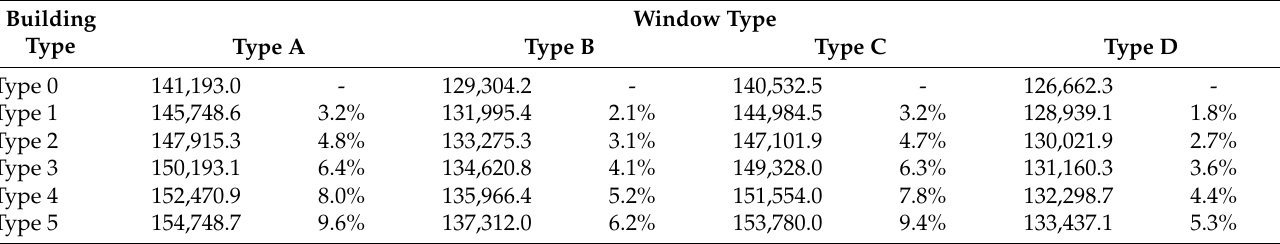
Table 7. Heat loss values for